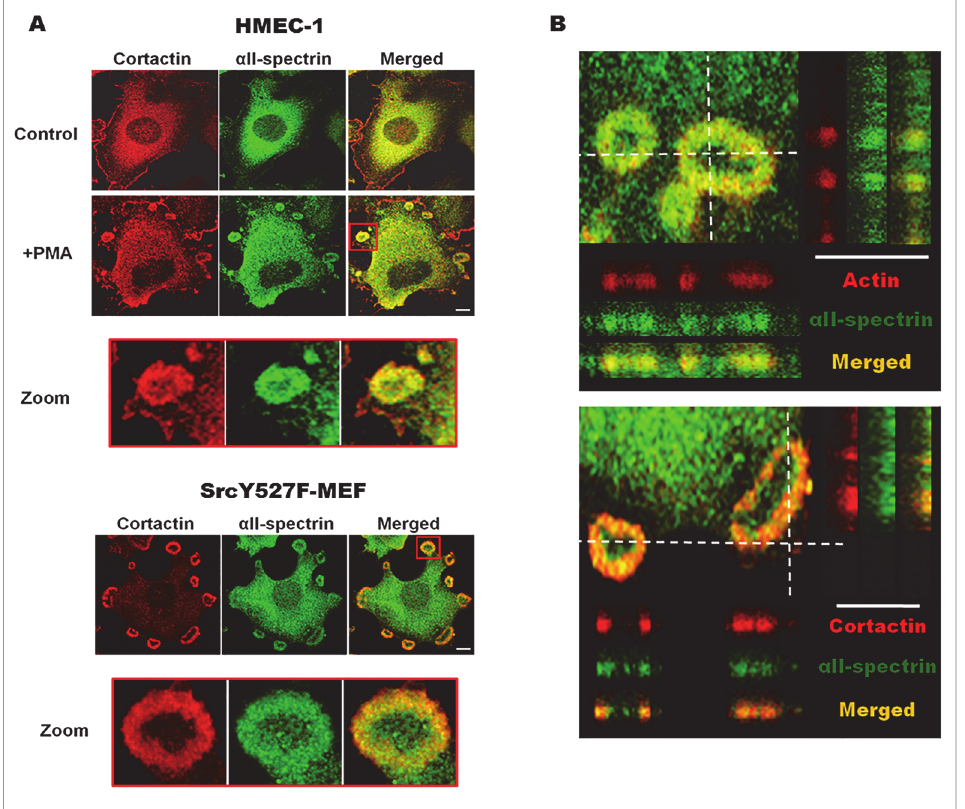
Fig 1. α II-Spectrin is localized in different invadosomes. (A) α II-Spectrin localization in PMA-treated HMEC-1 cells and SrcY527F-MEF cells. Starved HMEC-1 cells were treated for 1hr with PMA (50 ng/ml) in order to induce characteristic invadosome rings (zoom red square). Then, endogenous cortactin and α II-spectrin were stained and α II-spectrin relocalization after invadosome induction visualized. The presence of endogenous α II-spectrin was also seen in invadosome rings from SrcY527-MEF cells. (B) 3D localization of α II-spectrin in invadosomes. Confocal Z-stacks were obtained in SrcY527F-MEF cells stained for cortactin or F-actin. α II-Spectrin dashed lines represent the projected areas (Y section is projected on the right and X section on the bottom of the image), showing preferential α II-spectrin localization at the basis of the invadosome ring. Scale bar: 5 μ m.